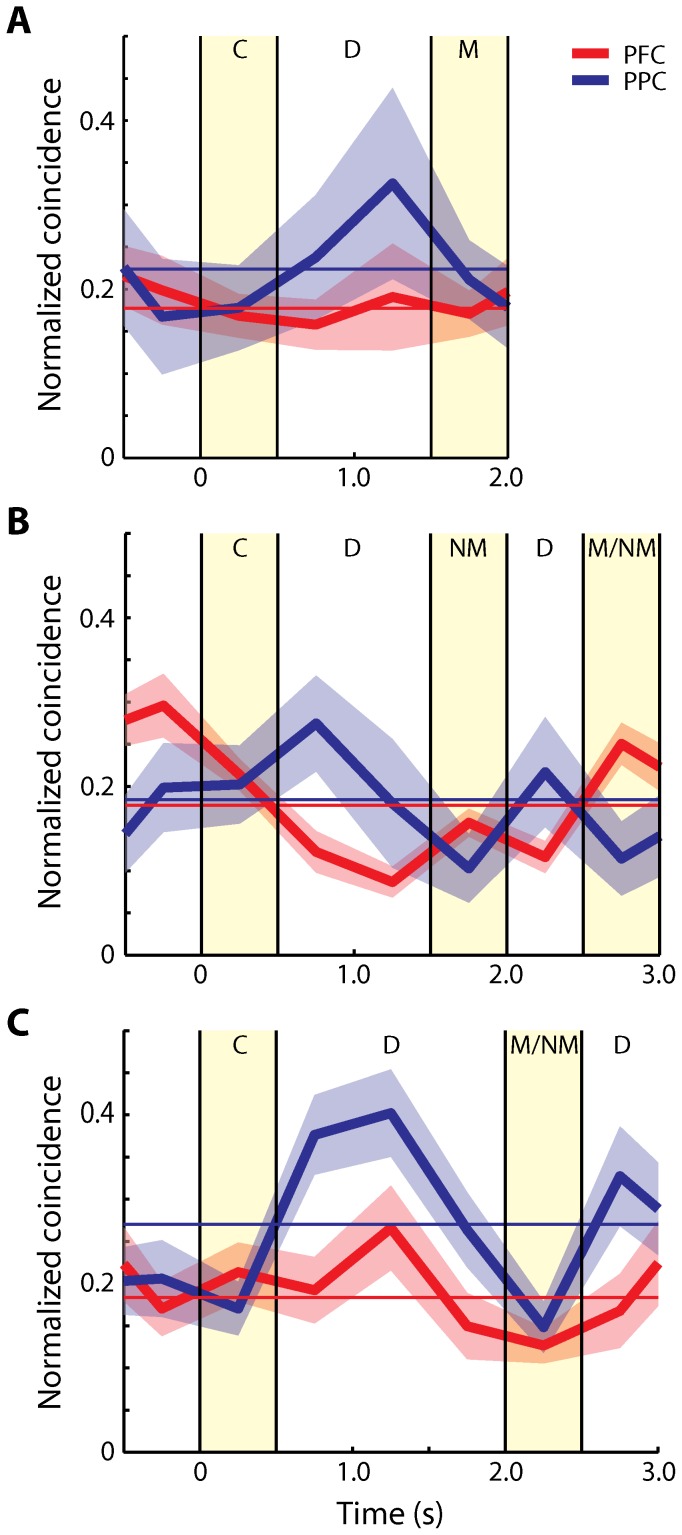
Time course of average effective connectivity for different trial types.Average normalized coincident spikes occurring within the center bin of the PSCCHs are plotted for the dlPFC (red) and the PPC (blue) for each trial type. Samples include all task-modulated neuron pairs. A) Trials in which cue period was followed by a match in the Delayed Match-to-Sample task (dlPFC: 225 pairs, PPC: 48 pairs). Shaded area along each trace represents one standard error of mean computed across neuron pairs. The first yellow shaded area represents the cue period, and the second one represents the match period. Horizontal solid lines represent the mean over the period depicted in the plot. B) Trials in which the cue period was followed by a non-match stimulus in the Delayed Match-to-Sample task (dlPFC: 371 pairs, PPC: 66 pairs). The first yellow shaded area represents the cue period, the second one represents the first non-match period, and the third one represents the second non-match/match period. C) Trials in the Match-Nonmatch task (dlPFC: 171 pairs, PPC: 95 pairs). The first yellow shaded area represents the cue period, the second one represents the second stimulus presentation period.